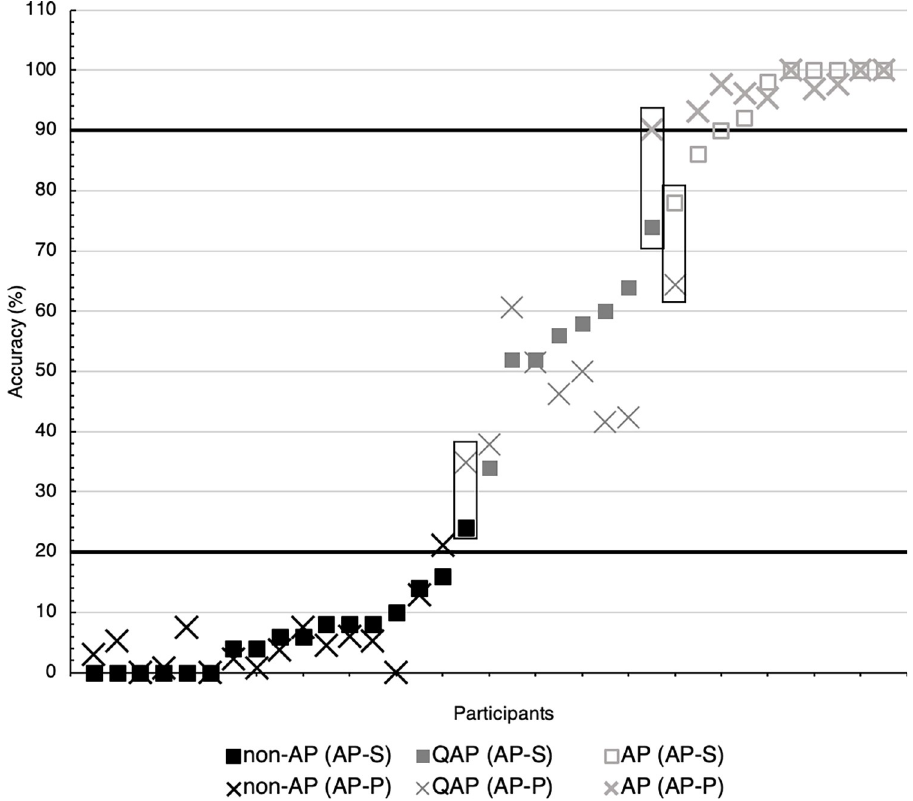
Fig 3. Distribution of accuracy scores. Distribution is shown across AP-S (squares) and AP-P (crosses), with groupings according to the three-group LPA solutions for each task (black = non-AP, dark grey = QAP, light grey = AP). The highlighted boxes refer to the three participants whose group allocation changed between AP-S and AP-P LPAs. For example, the participant in the right-most box scored 78% in AP-S and was allocated to the AP group, but only 64% in AP-P and was placed in the QAP group. Horizontal lines at 20% and 90% indicate commonly employed thresholds for AP ( > 90% accuracy) and non-AP ( < 20% accuracy).